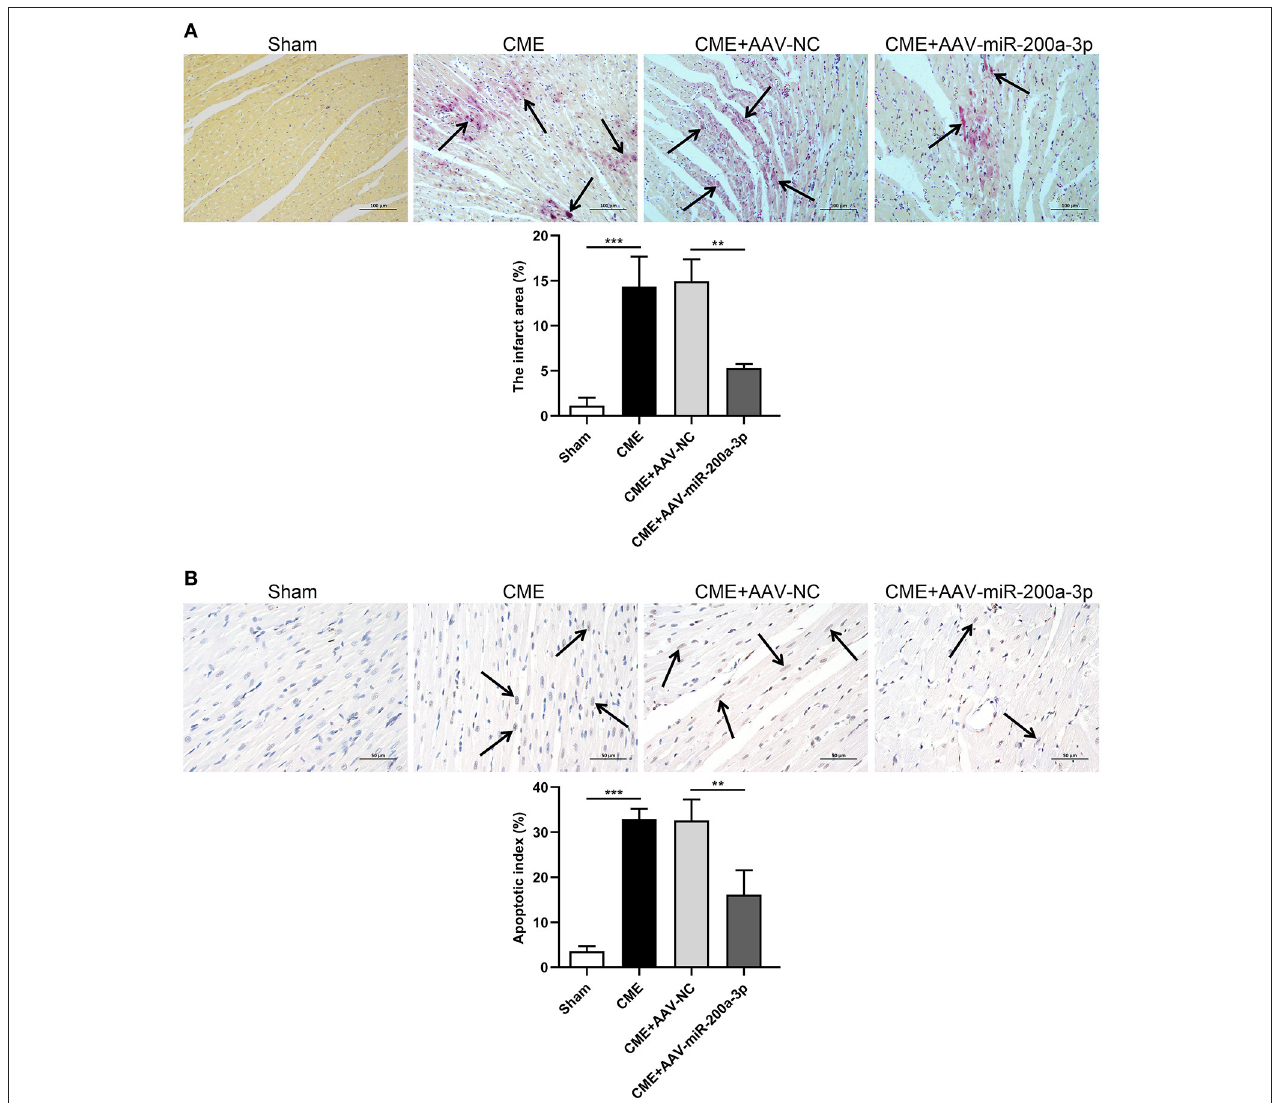
FIGURE 5 | miR-200a-3p overexpression decreases CME-induced myocardial microinfarct size and alleviates cardiomyocyte death. (A) HBFP staining ( × 200 magnification; bar = 100 µ m) was used to detect normal (yellow) and ischemic (red) cardiomyocytes in myocardial tissues. Arrows are used to denote the microinfarct area ( n = 3 per group). (B) TUNEL staining ( × 400 magnification; bar = 50 µ m) was used to detect normal (light blue) and apoptotic (yellow-brown) cardiomyocytes in myocardial tissues. Arrows are used to denote apoptotic cardiomyocyte nuclei ( n = 3 per group). The data are presented as the mean ± standard deviation (SD). **